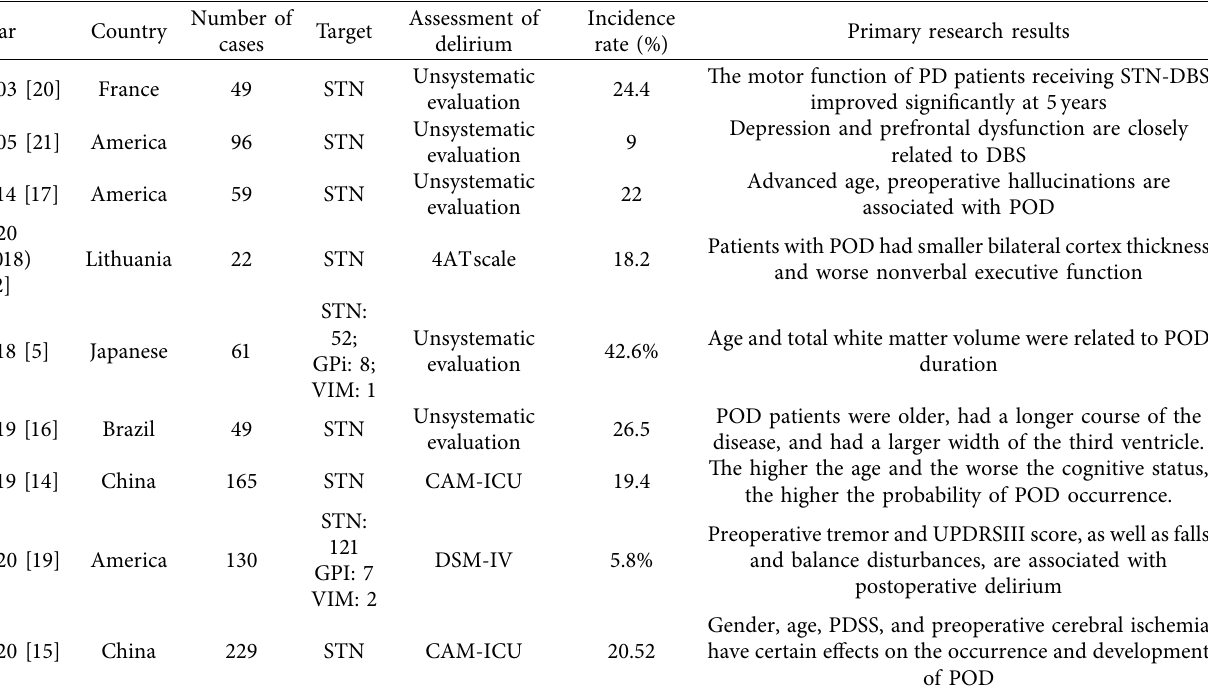
Table 1: Recent studies on postoperative delirium or postoperative confusion following DBS.